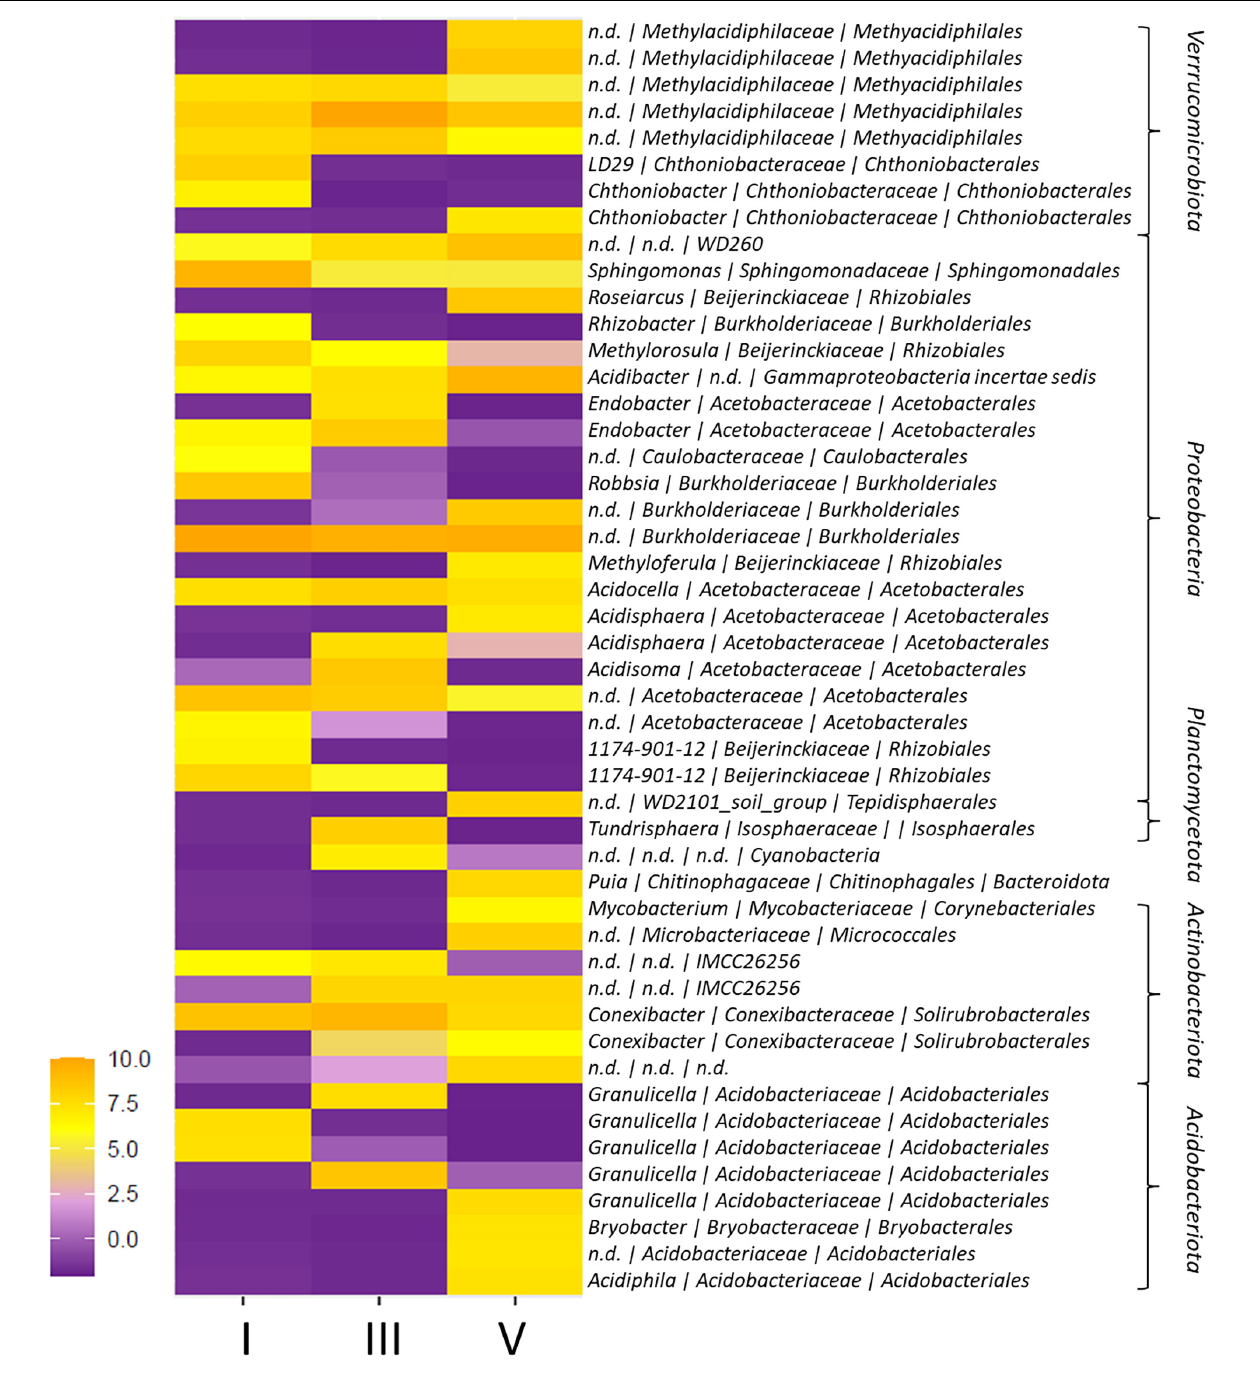
FIGURE 2 | Heatmap of ASVs with differential abundance among decay classes (DCls) I, III, and V. The differential abundance of ASVs among DCls was evaluated using generalized linear modeling (ALDEx2). Only ASVs with a significant, Bonferroni-Holm corrected p -value are shown. Taxonomy indicates genus | family | order and phylum